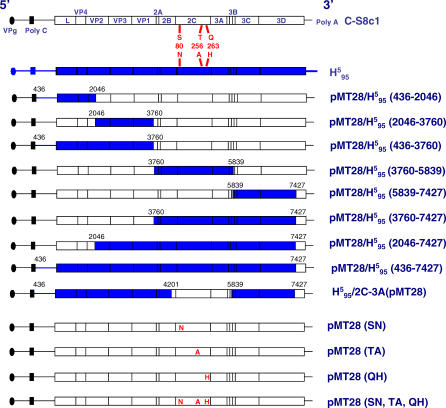
Scheme of the FMDV Genome, Chimeric Viruses, and 2C MutantsThe C-S8c1 and
regulatory regions are represented as black and blue lines, respectively; the corresponding coding regions are represented as white and blue boxes, respectively. pMT28 refers to the plasmid that encodes infectious RNA transcripts with the C-S8c1 nucleotide sequence [22]. Chimeric viruses are colored blue and named with the first and the last nucleotide that correspond to the
genomic region. Chimera
/2C-3A(pMT28) includes 2C, 3A, and parts of 2B and 3B of pMT28 in the background of residues 436 to 7427 of
. Amino acid substitutions in protein 2C are indicated in red. The residue numbering of the FMDV genome is as in [11]. Procedures for the construction of chimeric viruses and 2C mutants are described in Materials and Methods.